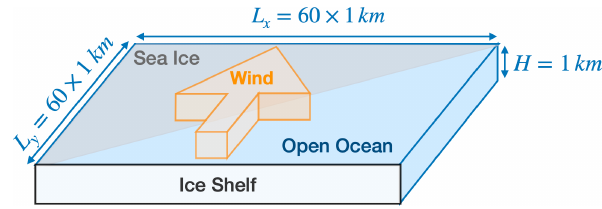
Figure 5. Model schematic. Sea ice is indicated by the pale grey patch covering the northwestern half of the gyre domain. The or- ange arrow indicates the wind direction, perpendicular to the ice shelf